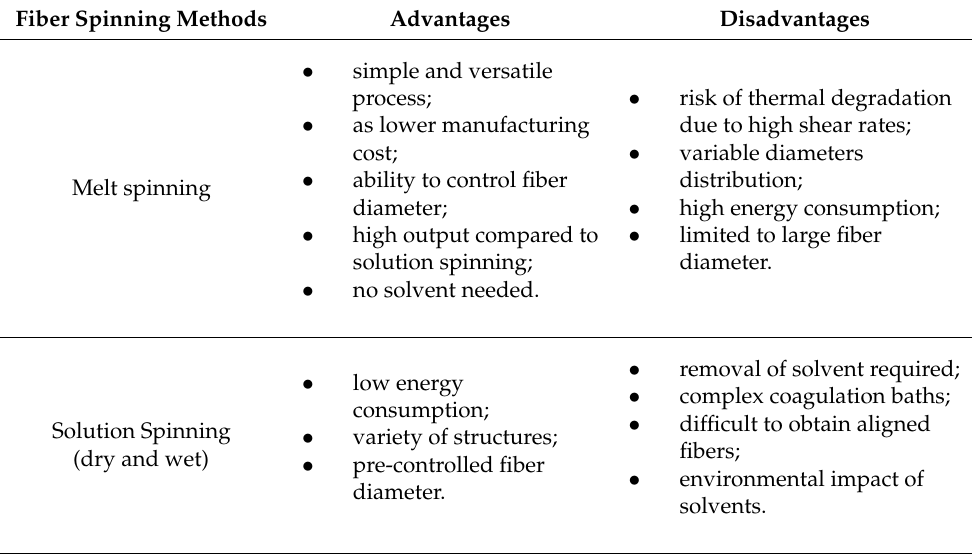
Table 5. Comparison of the different fiber spinning technologies